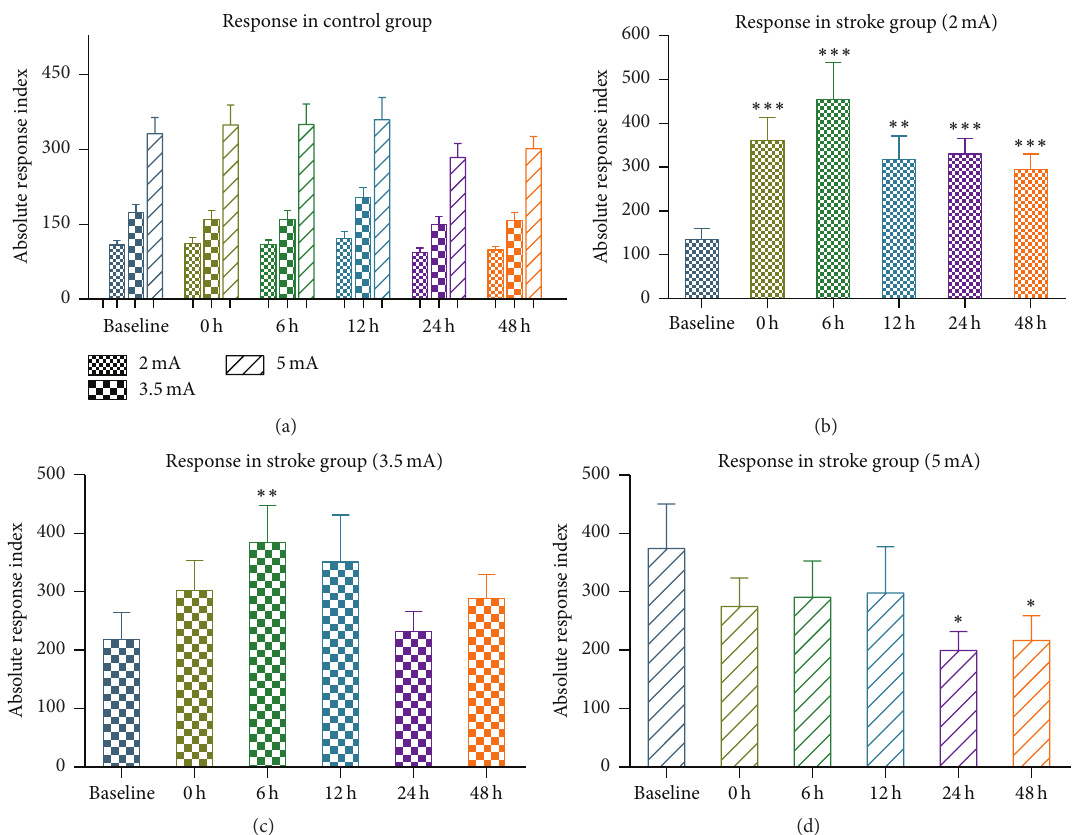
Figure 5: Absolute responses to different stimulation intensities in Control group and Stroke group. (a) Absolute response index in Control group. (b–d) Absolute response index in Stroke group to stimulations at 2 mA, 3.5 mA, and 5 mA, respectively. Error bars represent SEM